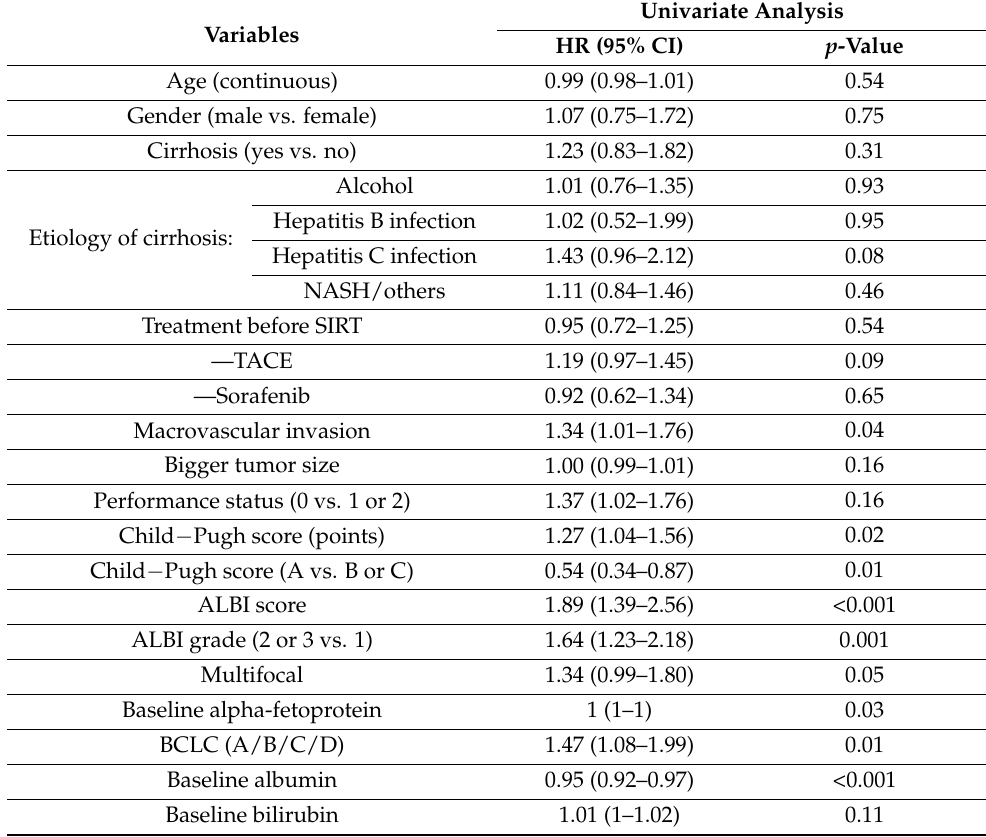
Table 2. Univariate analysis using a Cox model for overall